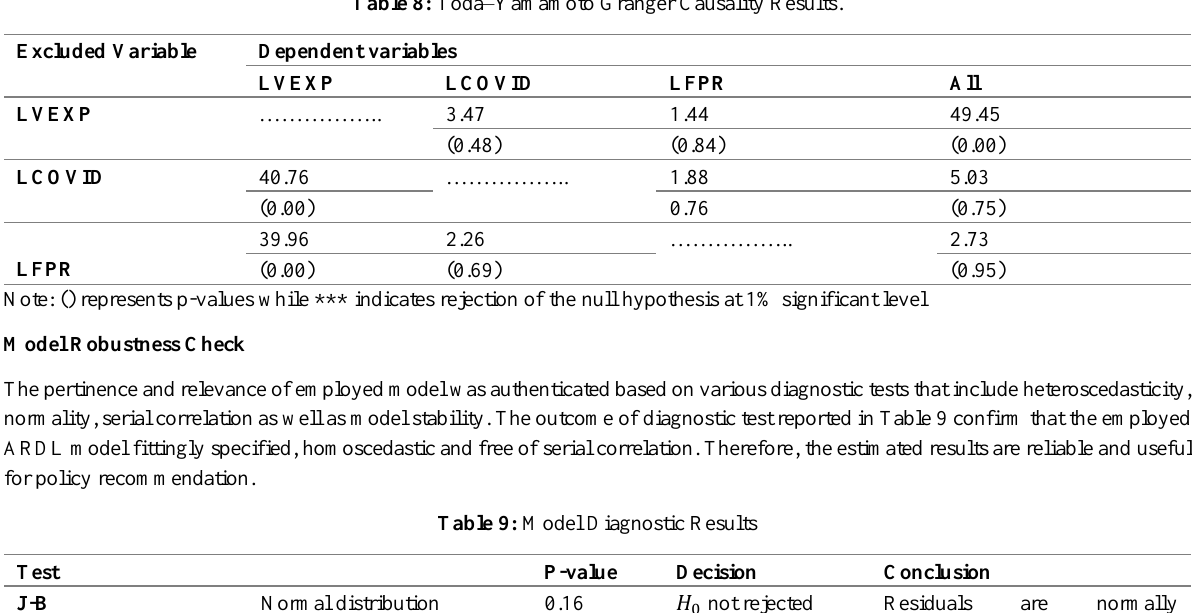
Table 8: Toda–Yamamoto Granger Causality Results.